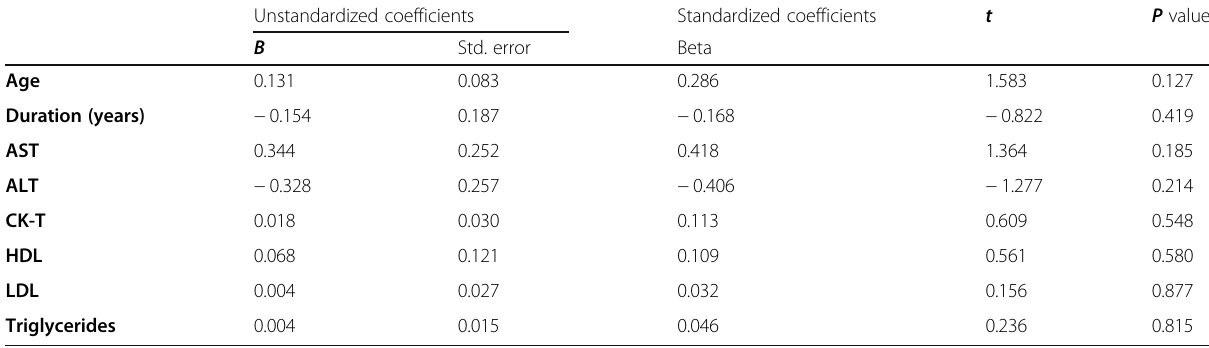
Table 5 Linear regression analysis displaying independent predictors of hs-CRP at baseline Unstandardized